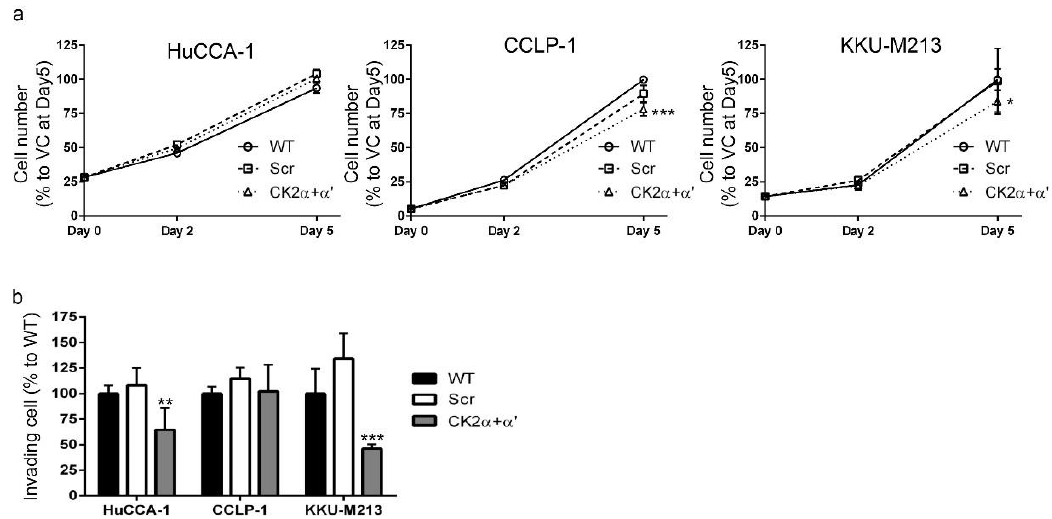
Figure 8. CK2 knockdown had little effect on CCA cell proliferation but inhibited cell invasion. ( a ) Knockdown of α and α′ catalytic subunits of protein kinase CK2 (Figure 7a) decreased CCLP-1 and KKU-M213 cell number as determined using MTT assays. ( b ) Knockdown of α and α′ catalytic subunits of protein kinase CK2 reduced HuCCA-1 and KKU-M213 cell invasion. WT; wild type, Scr; scramble siRNA, *; p < 0.05, **; p < 0.01, ***; p < 0.001. All experiments were performed as at least three biological replicates. Graphs were plotted as mean ± SEM.